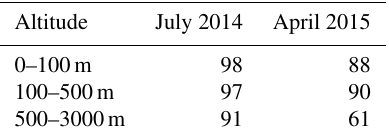
Table 2. Simulated campaign-mean percent contribution of DMS from oceans north of 66 ◦ N to the GEOS-Chem-simulated DMS at the sampling locations for the July 2014 and April 2015 flight